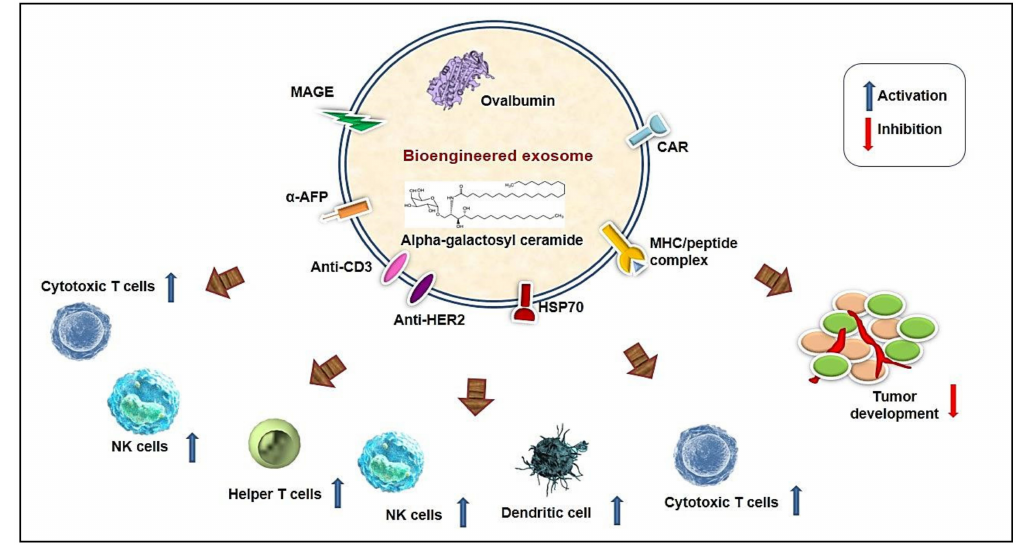
Figure 2. Bioengineering of exosomes for immune regulation: Modified exosomal cargoes and other molecules surface molecules regulate the activation of immune response and the inhibition of tumor development. CAR, chimeric antigen receptor; HER2, human epidermal growth factor receptor 2; HSP, heat shock proteins; MAGE, melanoma antigen gene; NK, natural killer